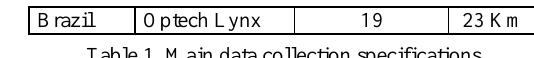
Table 1. Main data collection specifications